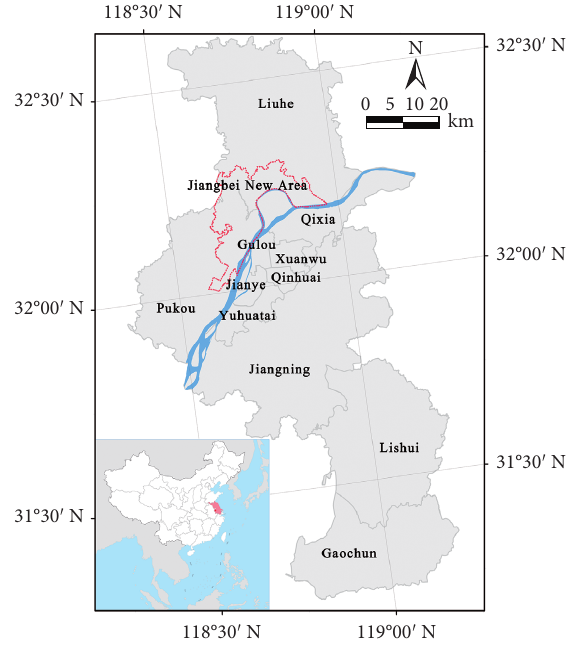
Figure 1: Study area